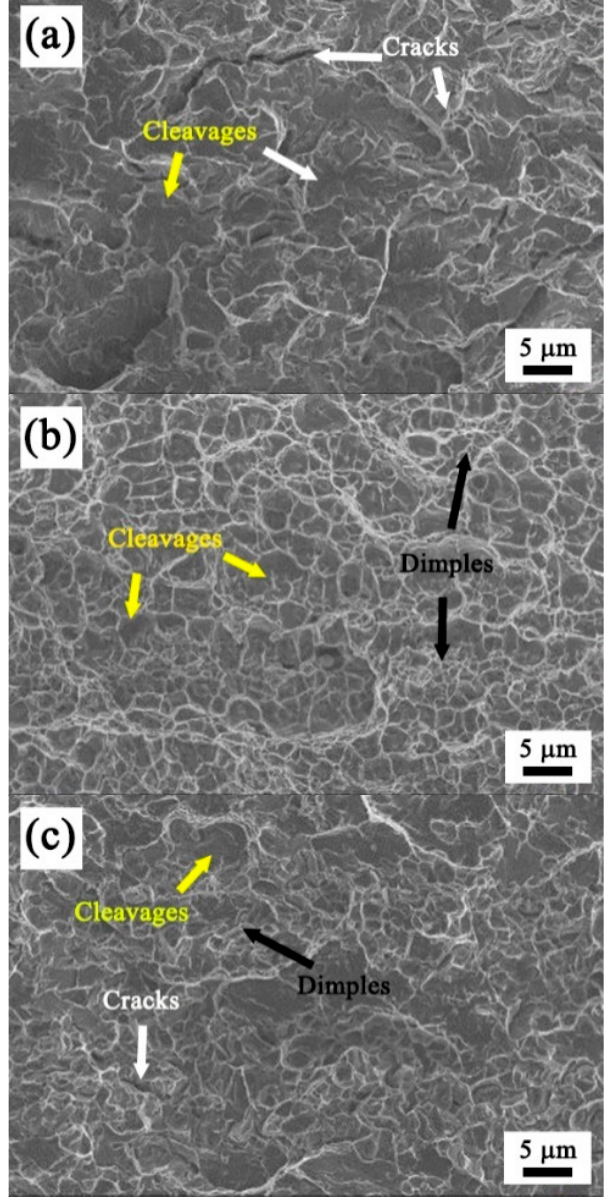
Figure 6. Fracture surface of ( a ) V-alloyed, ( b ) Nb-Ti-alloyed, and ( c ) Ti-alloyed steel. In order to further verify the mechanical properties of three different micro-alloyed Q&P steels in terms of ductility, toughness, and plasticity, numerical simulations of tensile processes were respectively performed for these steels based on ABAQUS software. The model dimensions of the tensile specimens were 20 × 1.5 mm 2 in the cross-section and 80 mm in the gauge length along the transverse direction. The mesh size of the numerical model was around 2 × 2 mm, and the material properties were set according to the engineering stress–strain curves in Figure 5. Figure 7 shows the stress distribution and necking shrinkage of each micro-alloyed Q&P steel before fracture damage. The fracture stress of Nb-Ti-alloyed steel was the most minor compared with other steels, with a value of 1.111 × 10 3 MPa, and the size after necking was also the smallest compared with others, with a value of 9.32 mm, which means that the ductility of Nb-Ti-alloyed steel was the largest, from 20 mm necking to 9.32 mm. Thus, the numerical simulation analysis results confirm that Nb-Ti-alloyed steel had better ductility and